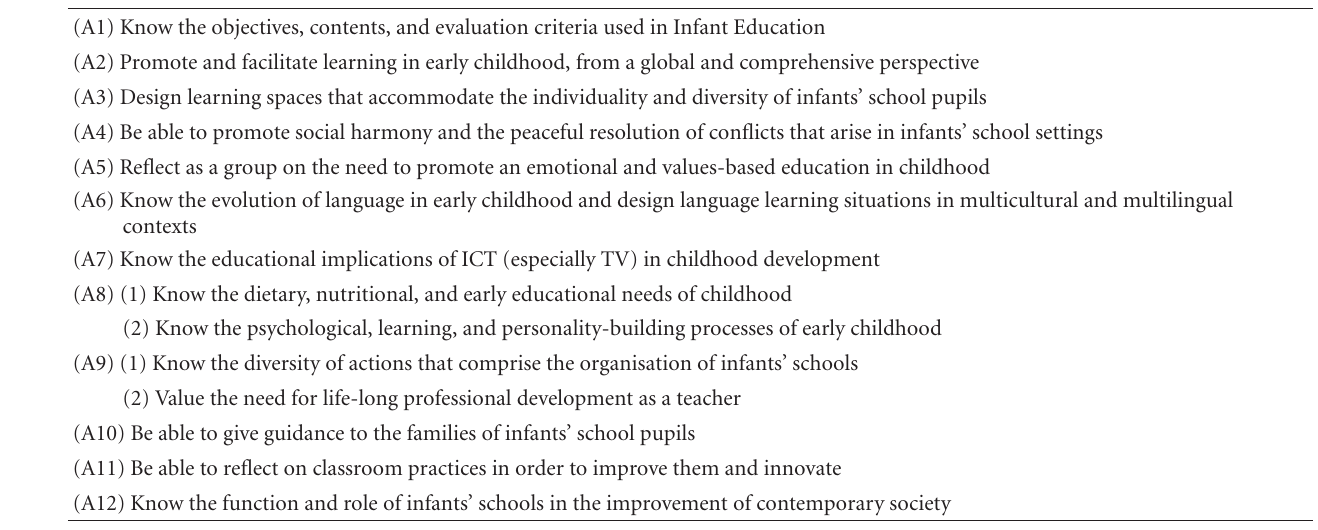
Table 1: Perceived average increases in the acquisition of professional skills, see also Figure 1 .